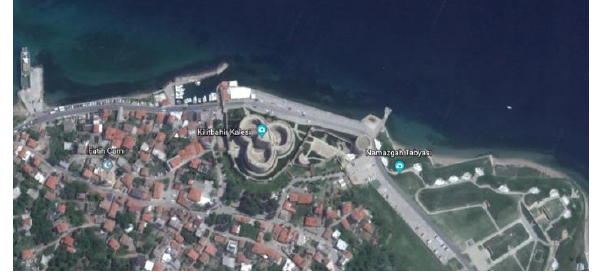
Figure 07 : Kilitbahir Castle, 40.15 ° N, 26.38 ° E coordinates